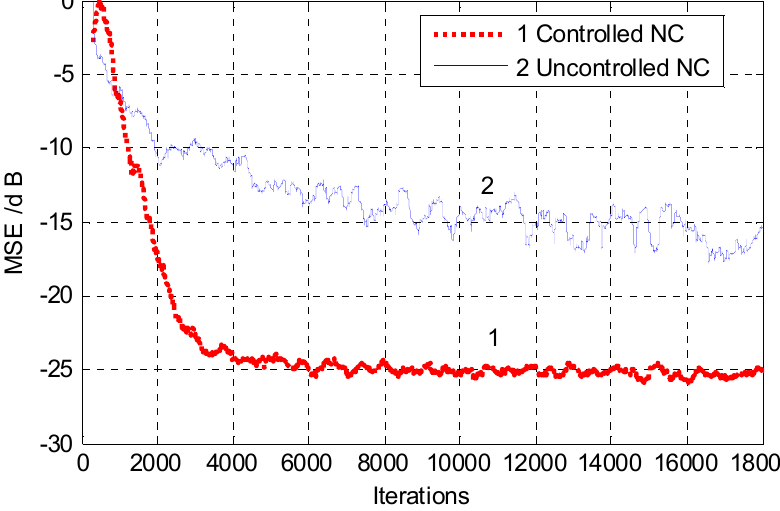
Figure 13. Mean square error convergence of controlled and uncontrolled noise cancellers.